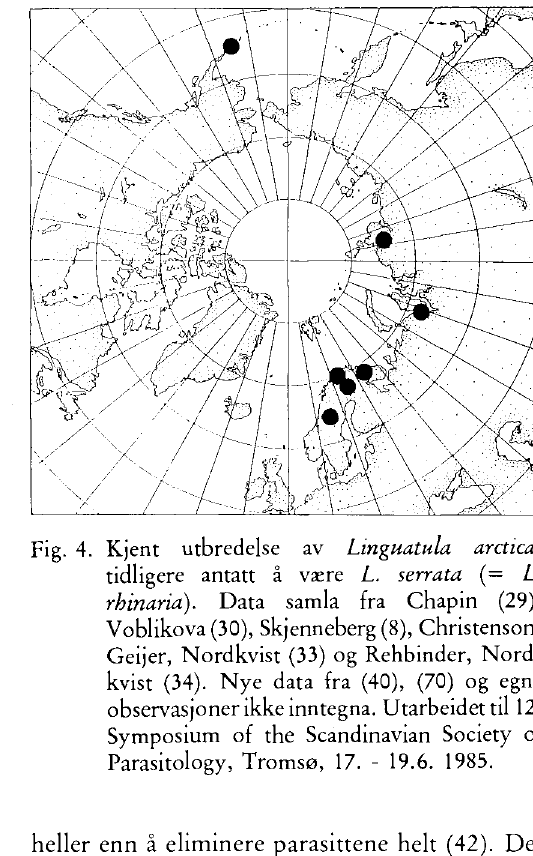
Fig. 4. Kjent utbredelse av Linguatula arctica, tidligere antatt å være L. serrata (= L. rhinaria). Data samla fra Chapin (29),